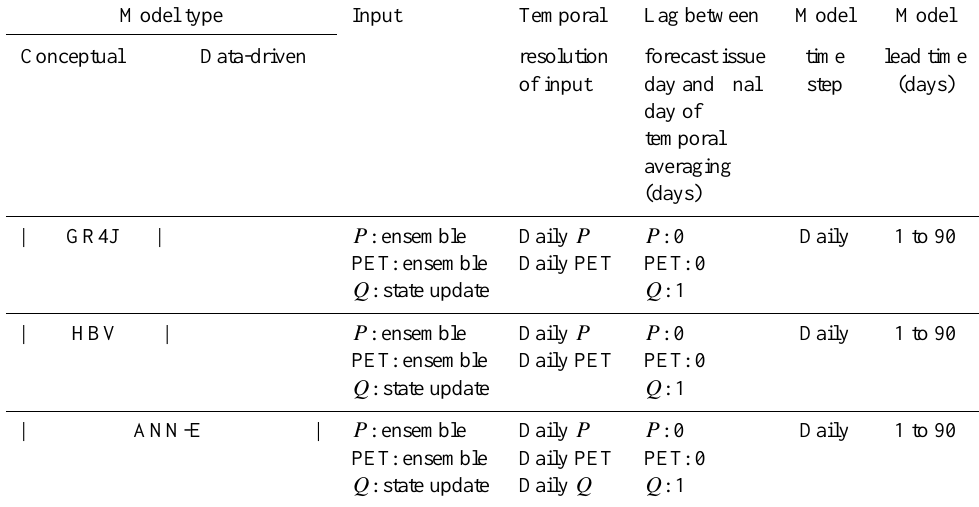
Table 3. Model descriptions. PET is potential evapotranspiration, P is precipitation and Q is